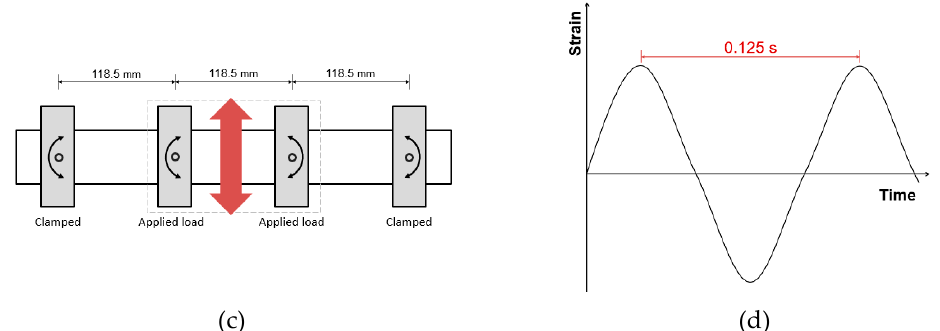
Figure 7. 4PB fatigue test: ( a ) beam samples, ( b ) 4PB testing schematic, ( c ) testing setup and ( d ) loading configuration.